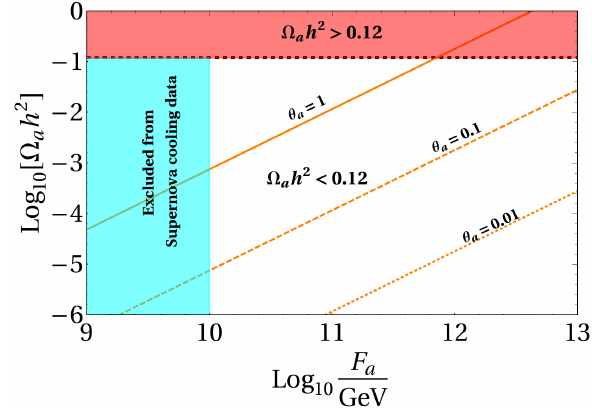
Figure 1. Variation of QCD axion relic density with the decay constant F a for three different values of misalignment angles: θ = 1 . 0 (solid), θ = 0 . 1 (dashed), and θ = 0 . 01 (dotted). Black a a a thick dashed line corresponds to observed relic Ω 2 = 0 . 12 . The cyan region is disallowed from DM h the Supernova cooling data. The light pink region corresponds to the parameter space where the DM relic density remains